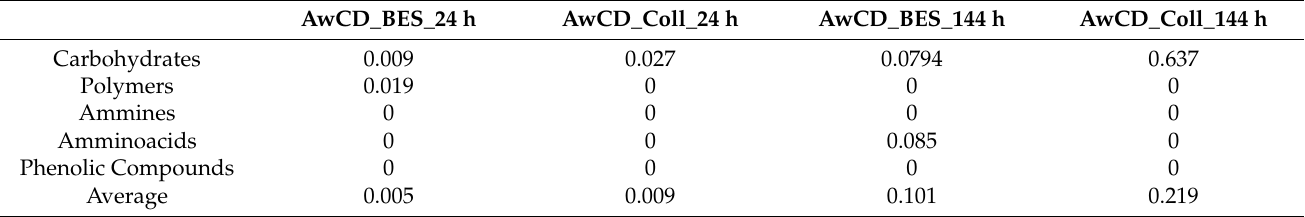
Table 3. AWCD values calculated for the four classes of carbon sources. The average values are calculated based on the reading of all 96